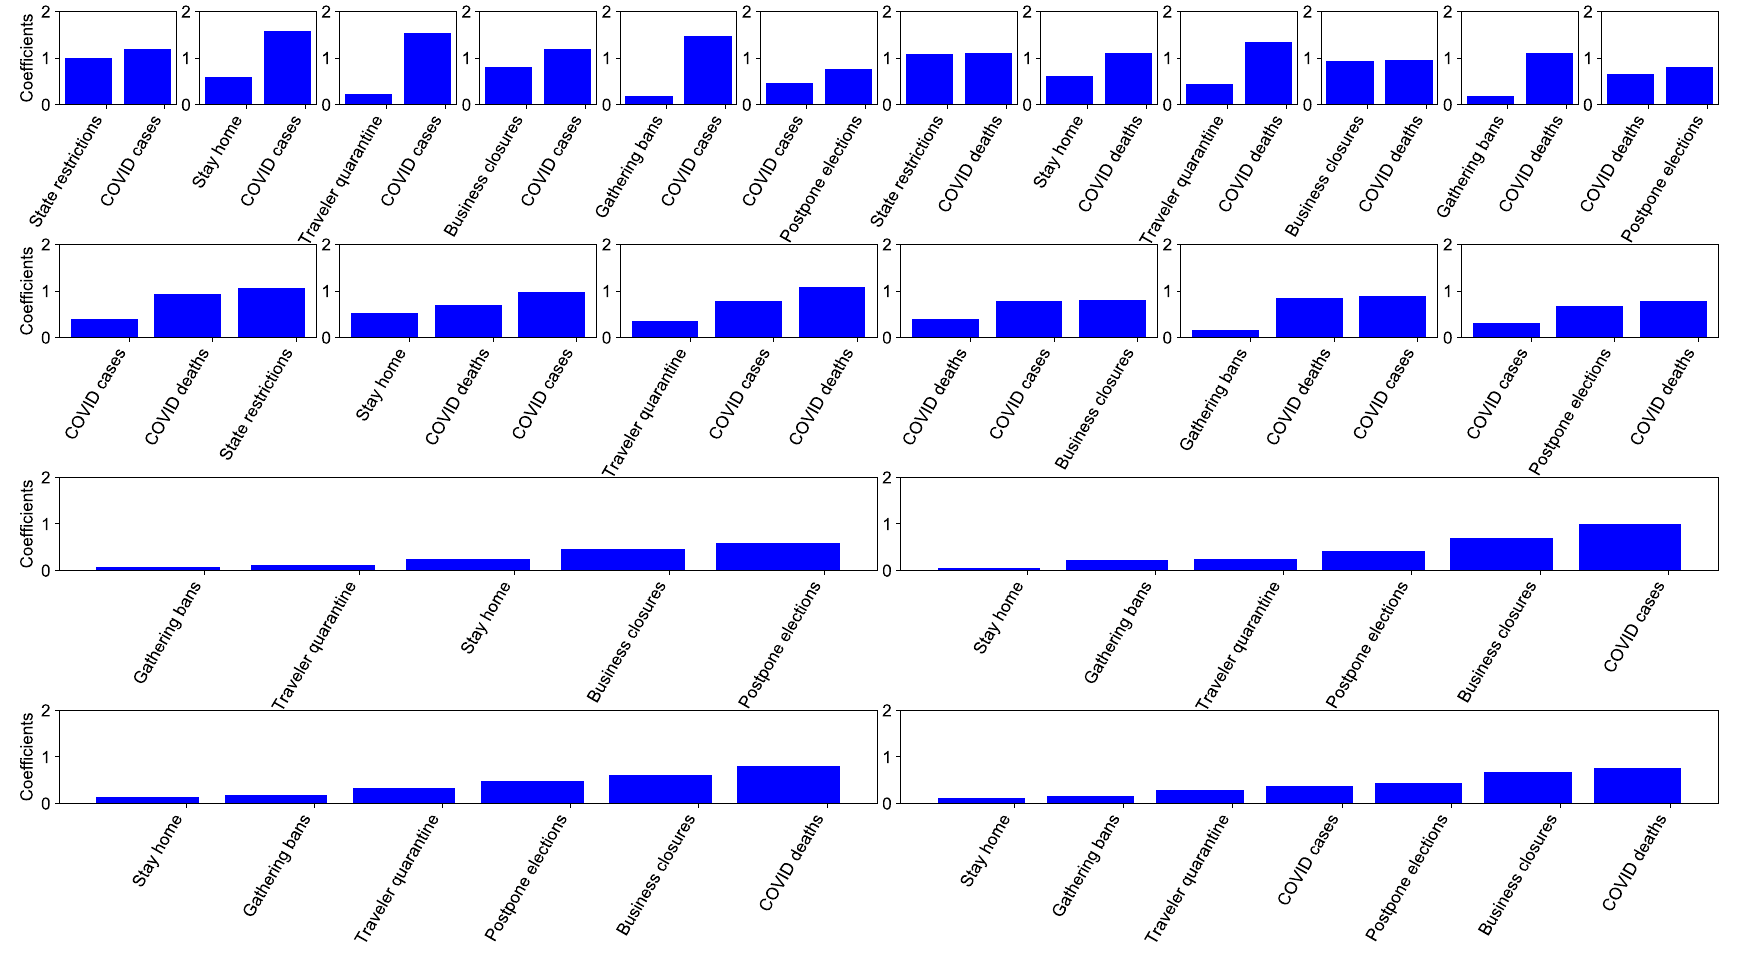
Figure 1. Feature importance rankings from machine learning evaluated models. The figure presents the relative importance rankings of machine learning for each model containing more than one feature from Table 6.